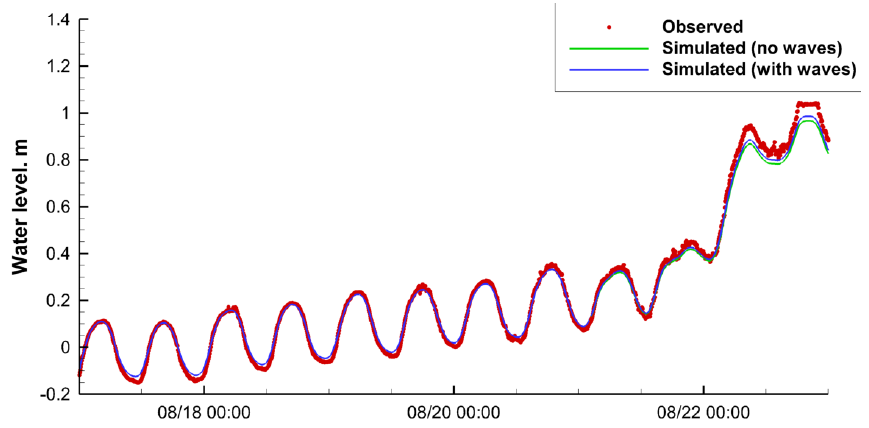
Figure 19. A comparison between the simulated (hindcast) and observed water levels at the I-295 Bridge Station (EC domain) during Tropical Storm Fay (2008).